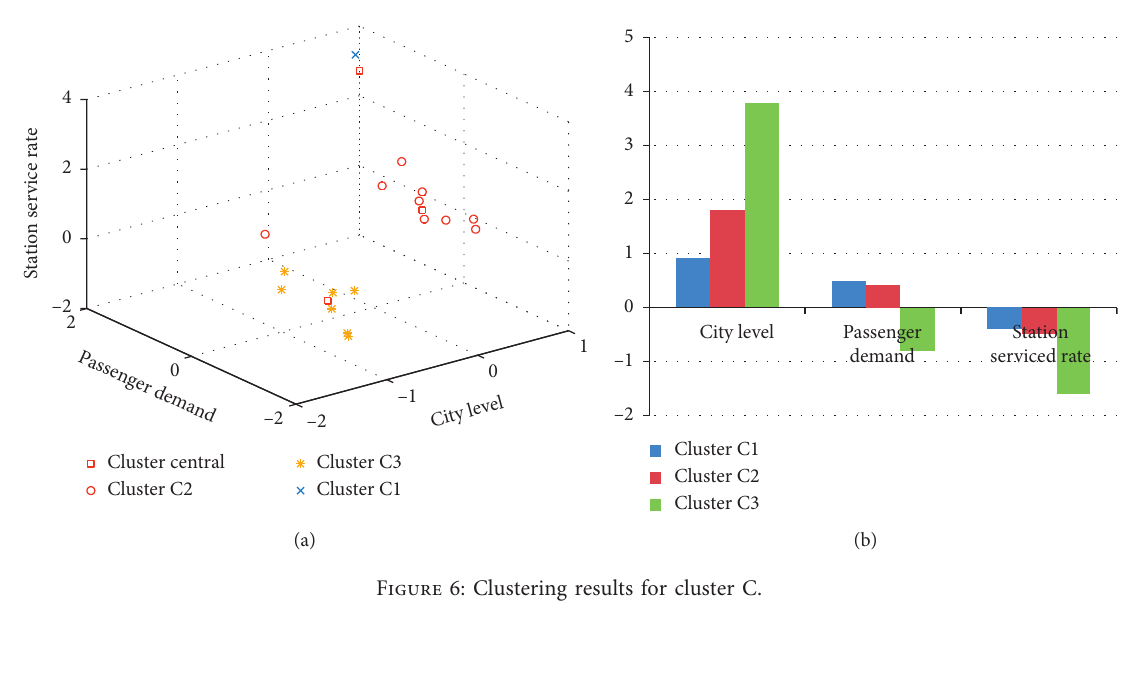
Figure 5: Clustering results for the stations.